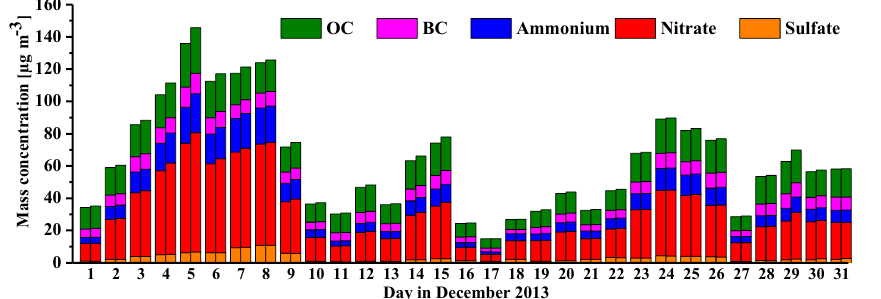
Figure 5. Chemical species of PM 2 . 5 simulated in MOD1 (left bar of each bar pair) and MOD2 (right bar of each bar pair) in December 2013.